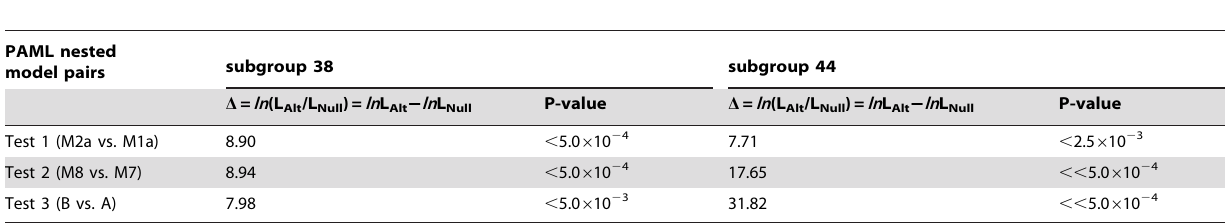
Table 5. P-value and likelihood ratio ( LR ) estimates from three PAML strategies for subgroups 38 and 44.